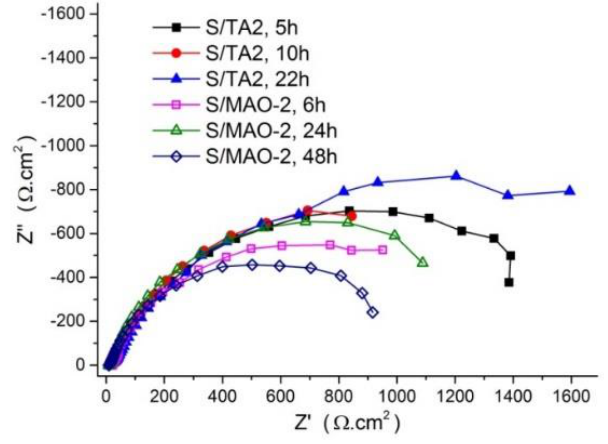
Figure 15. Nyquist diagrams of EIS for S/MAO-2 coupled together with S/TA2 coupled with time in 3.5% NaCl solution.